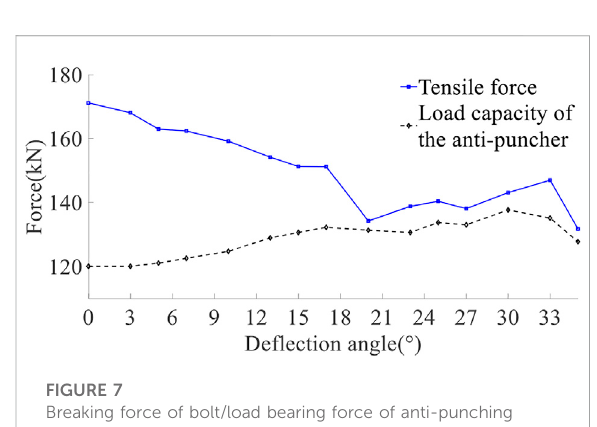
FIGURE 7 Breaking force of bolt/load bearing force of anti-punching device — de fl ection angle